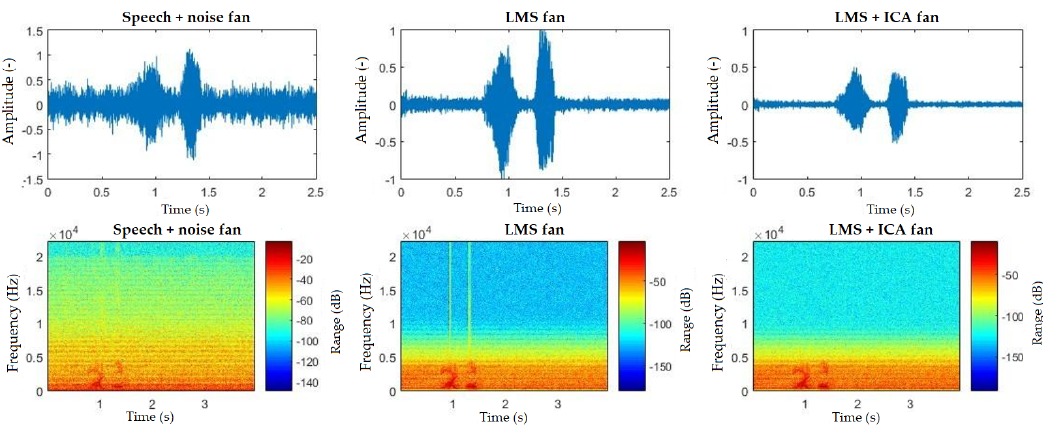
Figure 12. Comparison of spectrograms with closed windows, “light on” command, fan